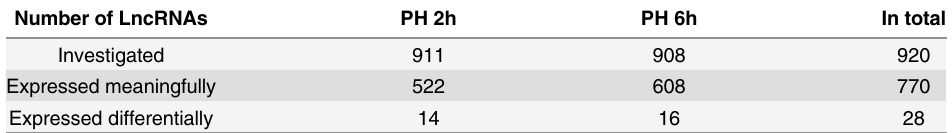
Table 1. The statistics of LncRNAs in the liver regeneration at different times.